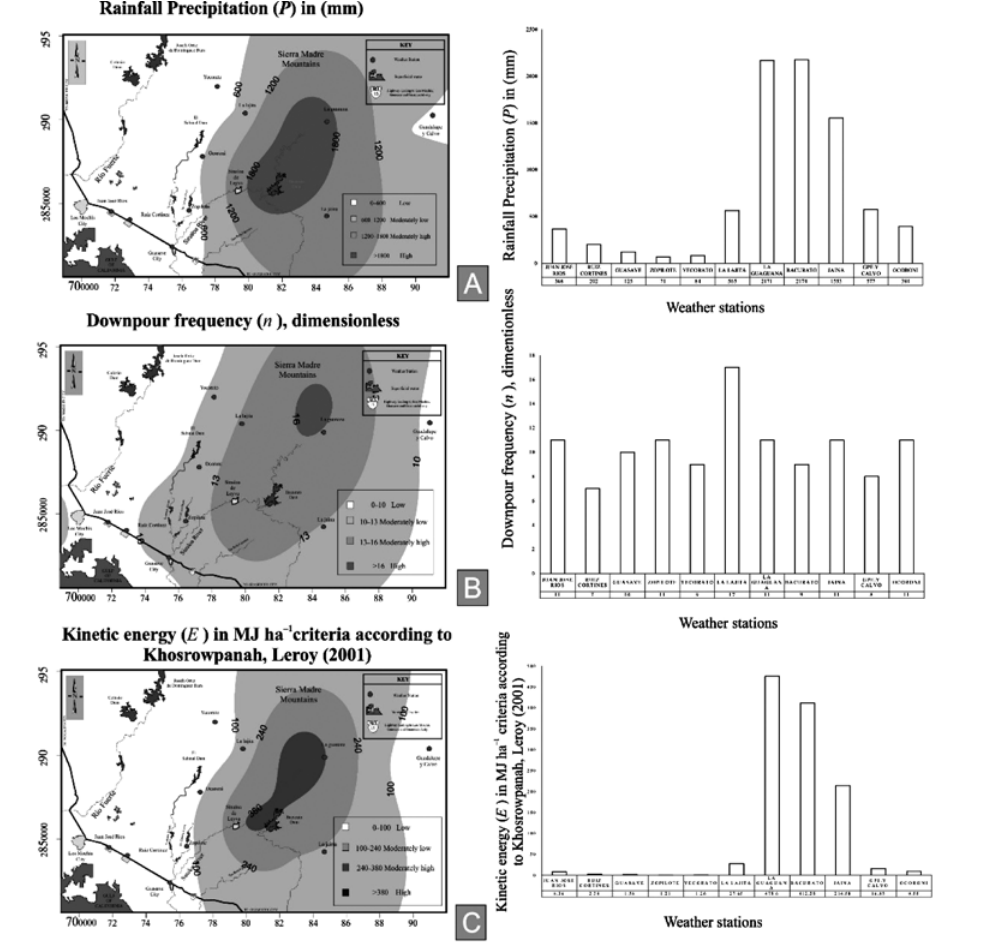
Fig. 2. (A) Spatial variation of annual average rainfall ( P ) in mm, (B) Spatial variation of annual numbers of downpours ( n ) and (C) total kinetic energy ( E ) of rainfall in MJ ha –1 in northwestern